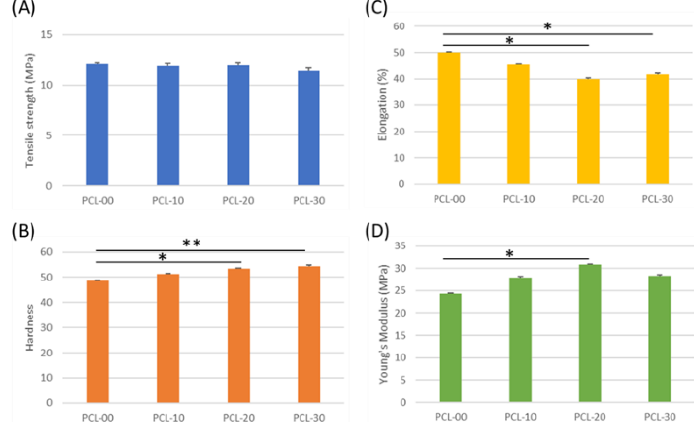
Figure 4. Mechanical analysis of different PCL/ β -TCP ratios. ( A ) Tensile strength, ( B ) Shore hardness, ( C ) elongation, and ( D ) Young’s Modulus were measured and calculated. Tensile and elongation specimens were prepared according to ASTM D412, while hard-ness was evaluated according to ASTM D2240. Significance is indicated by * when p < 0.05 and **, p < 0.01 compared to PCL-00.